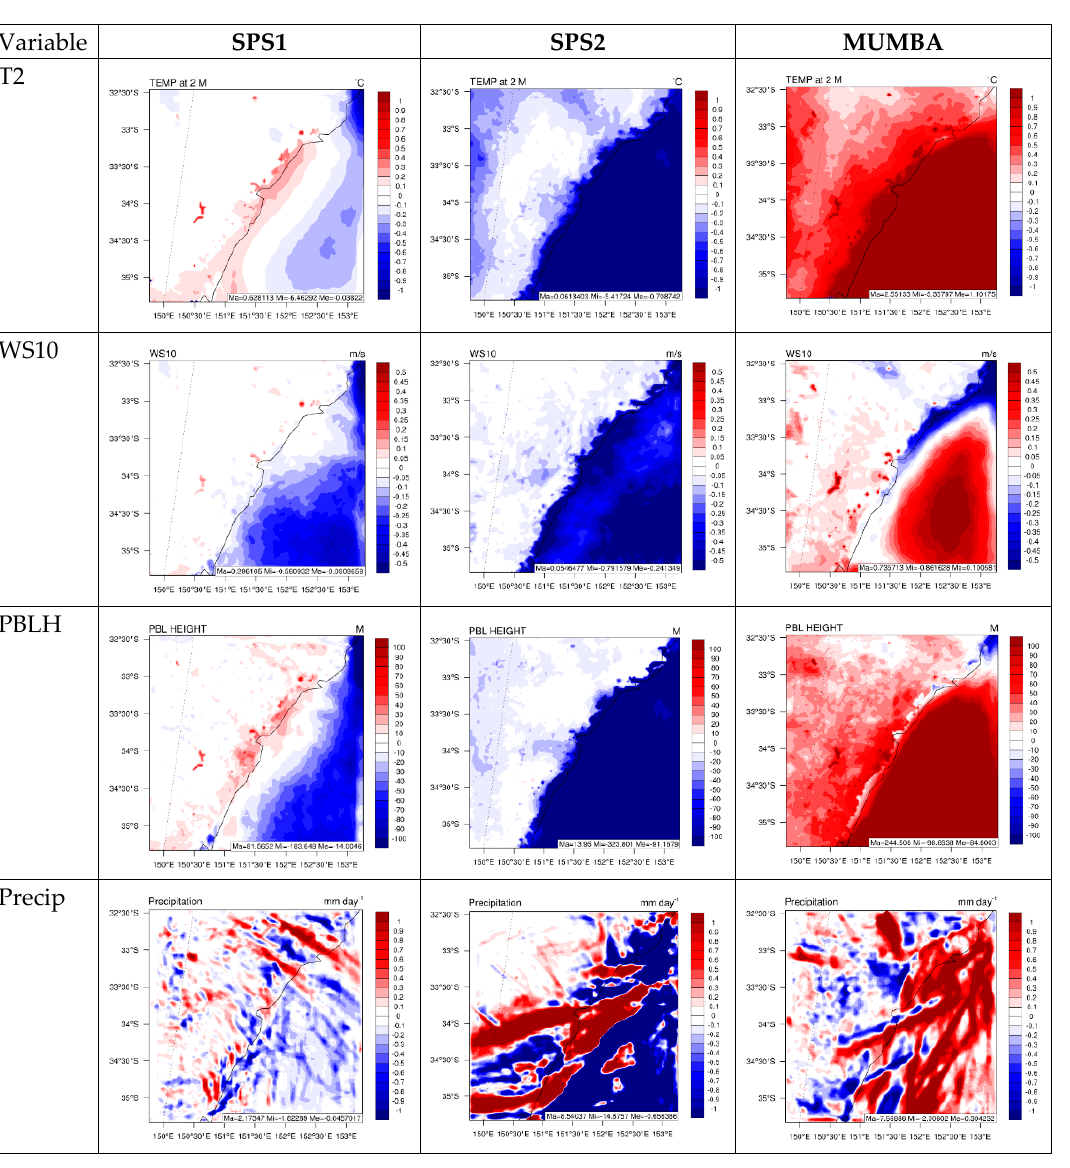
Figure 5. Absolute differences in simulated meteorological variables between WRF/Chem-ROMS and WRF/Chem-NCSU over the Greater Sydney (d04).